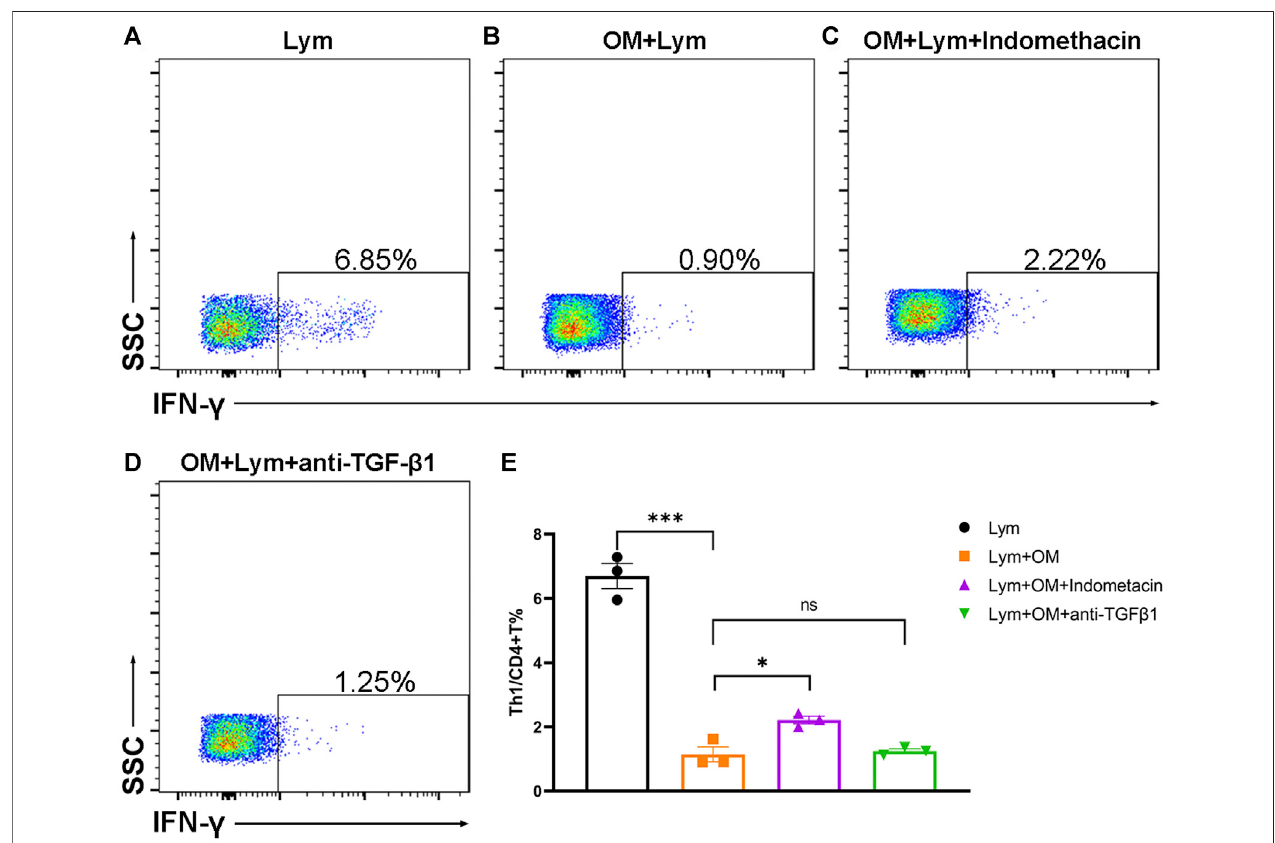
FIGURE 5 | OMSC inhibits the CD4+IFN- γ + T lymphocyte in vitro : (A – D) CD4+IFN- γ + T cell ratio in the human lymphocyte single culture group (A) , OMSC co- culture group (B) , COX inhibitor group (C) ,and TGF- β 1inhibitorgroup (D) . (E) Difference ofCD4+IFN- γ +T cell ratioamong the lymphocytesingle culture group, OMSC co-culturegroup,COXinhibitor group,and TGF- β 1inhibitor group( n (cid:1) 3). Lym:lymphocytes;OM:OMSC.* p < 0.05;*** p < 0.001;ns:thedifferencewasnotstatistically signi fi